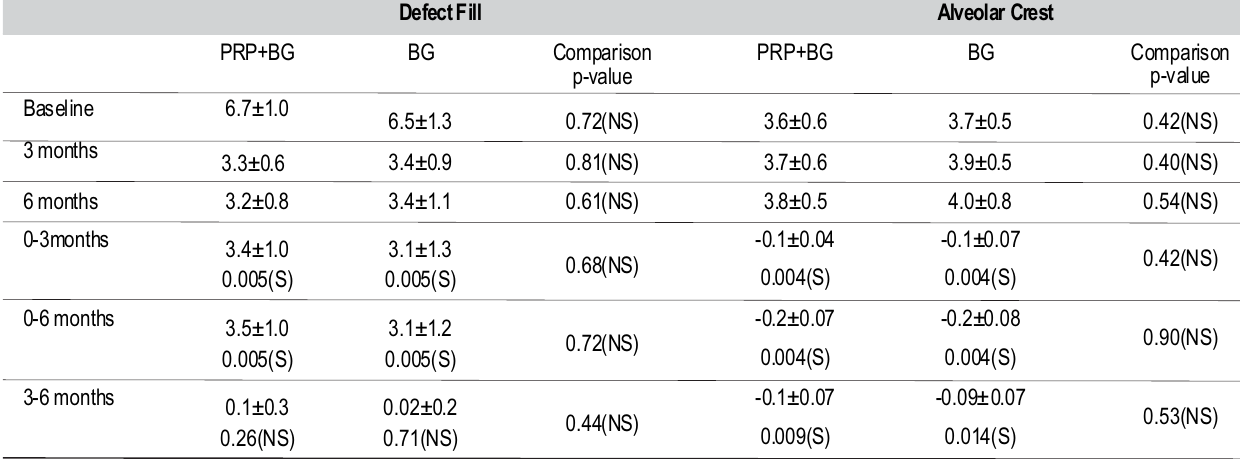
*Mean ± standard deviation; S, significant; NS, not significant; DF, defect fill; AC, alveolar crest